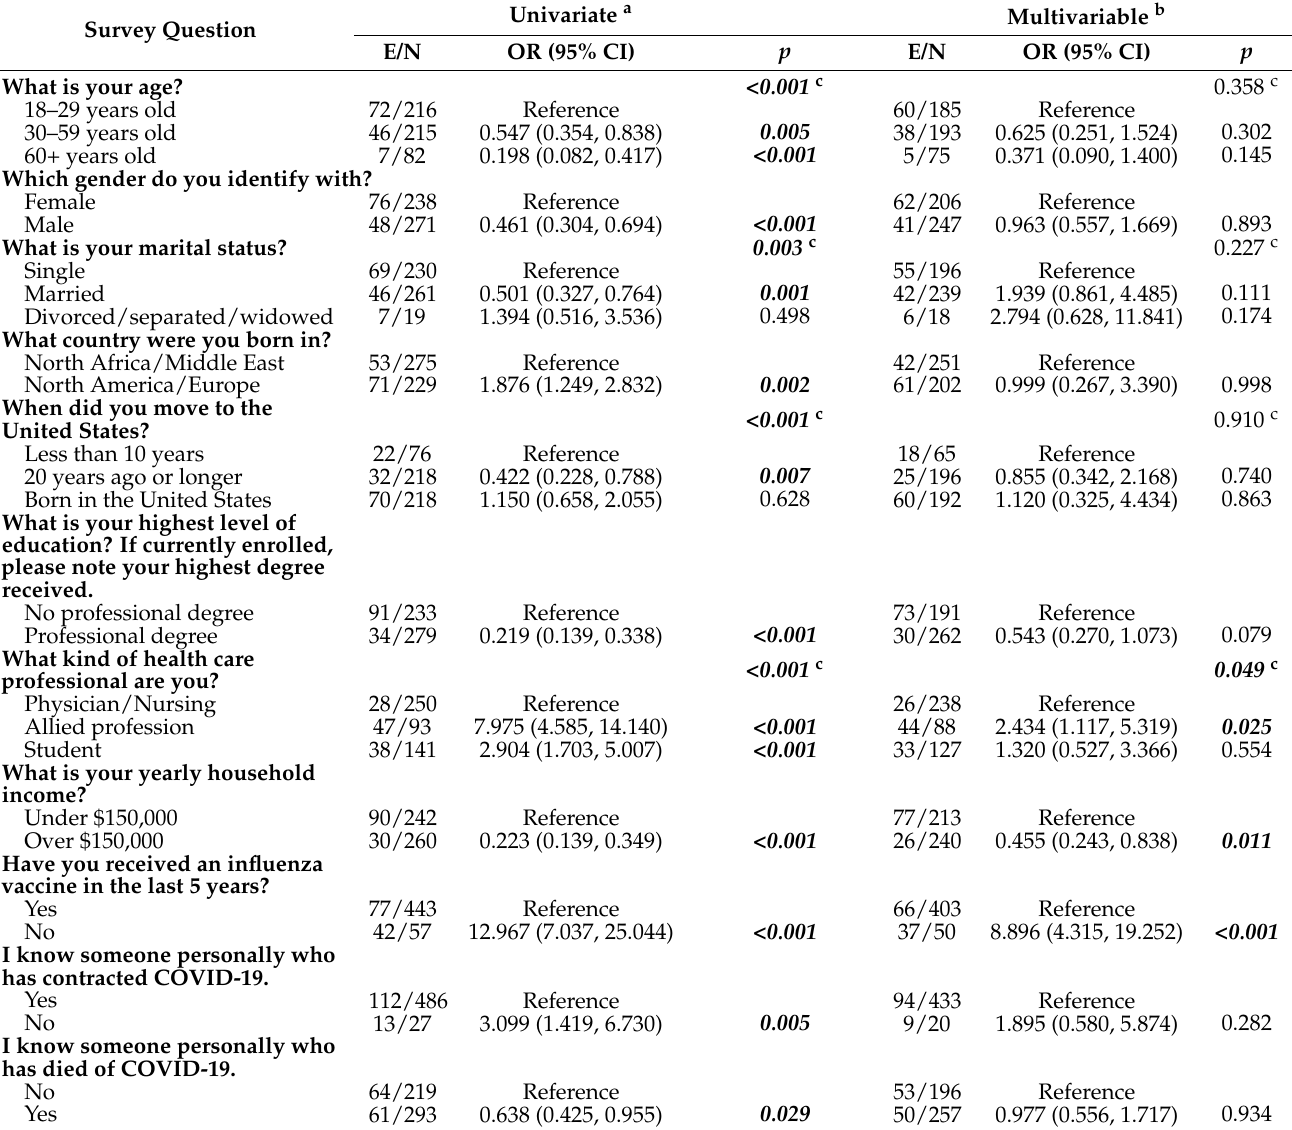
Table 3. Univariate and multivariable logistic regression analyses of risk factors associated with vaccine hesitancy (Yes vs. No, No as